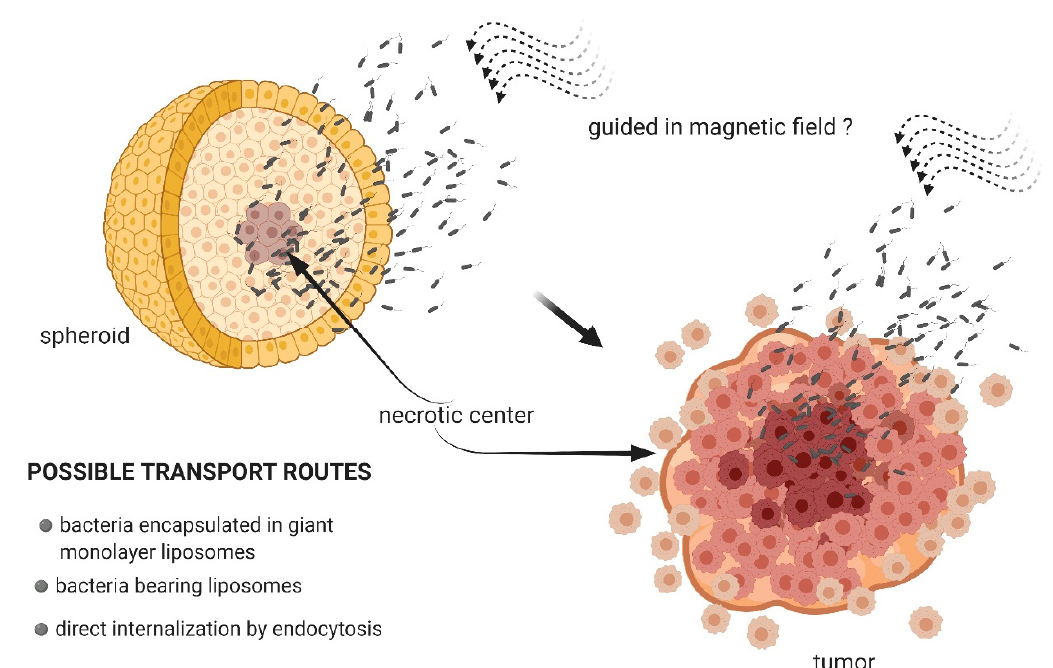
Figure 3. Magnetotactic bacteria as potential drug-carriers capable of penetrating the tumor.